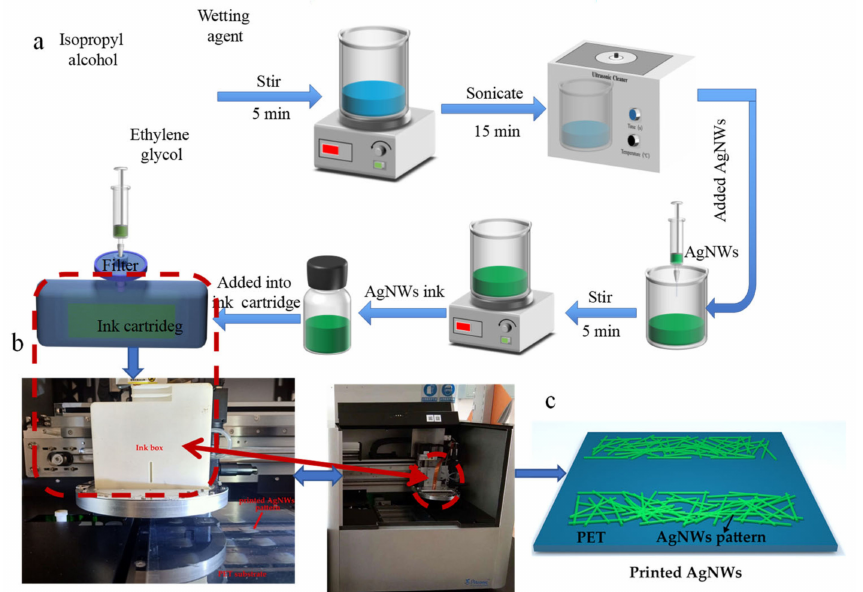
Figure 14. Schematic diagrams of the preperation of AgNWs ink ( a ) and inkjet printing equipment ( b ) and inkjet printed AgNWs patterns ( c